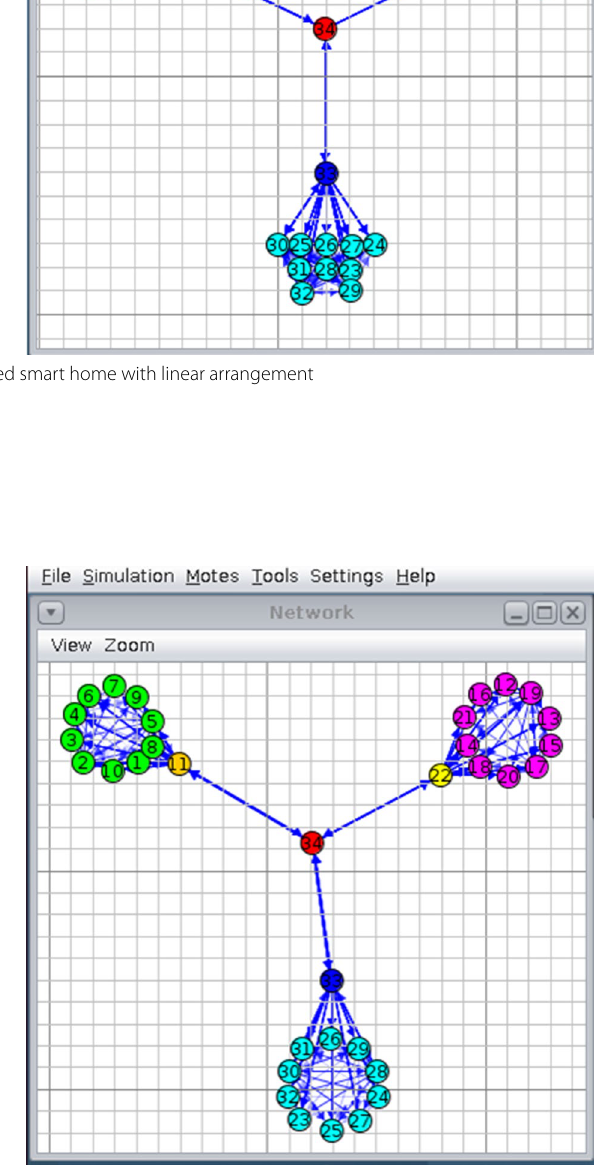
Fig. 11 Modified smart home with elliptical